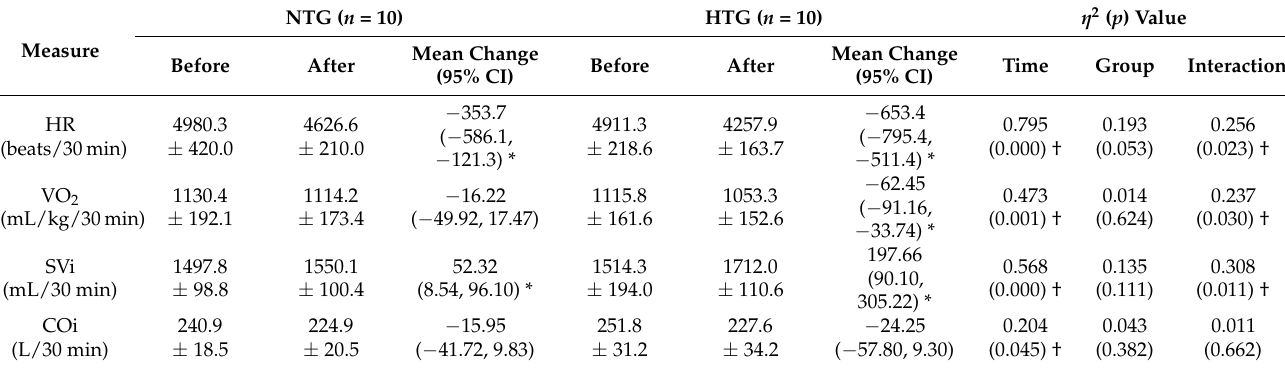
Table 4. Changes in hemodynamic function during submaximal exercise for 30 min before and after training by group.